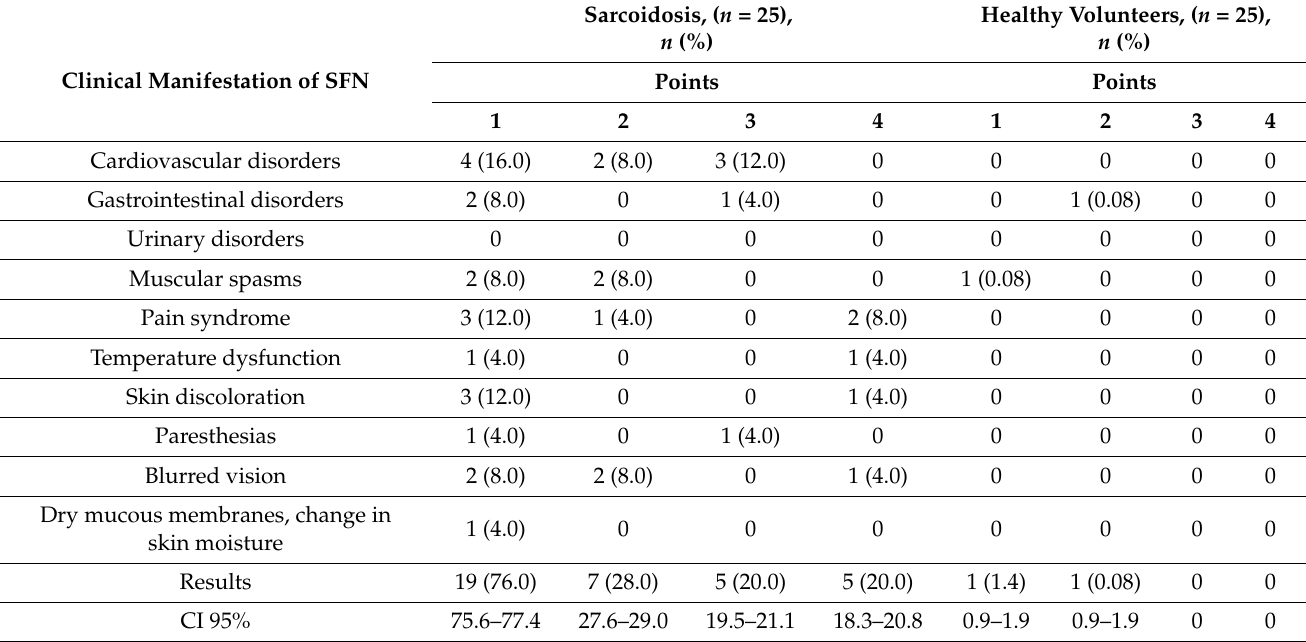
Table 3. Clinical manifestations of small fiber neuropathy in patients with sarcoidosis and healthy volunteers.